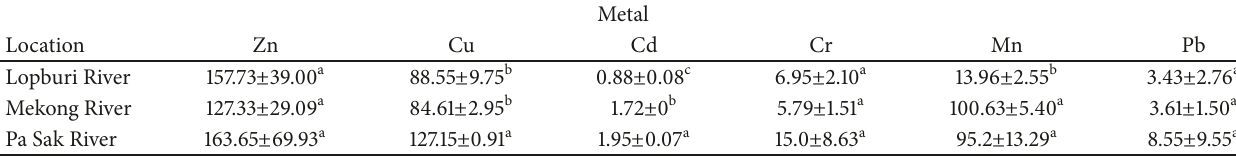
Table 1: Mean concentrations of Zn, Cu, Cd, Cr, Mn, and Pb ( 𝜇 g/g ± SD) in freshwater Asian clam. Metal